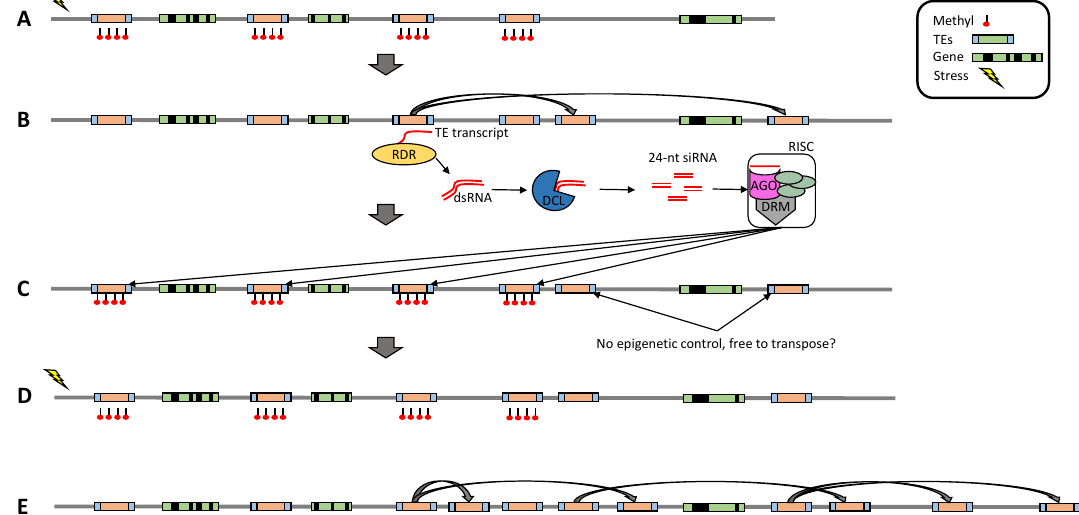
Figure 3. Potential mechanism of genome size increase due to TEs. ( A ) Multiple copies of a TE are demethylated upon stress; ( B ) TEs jump to new locations increasing genome size. At the same time, TE transcripts are recruited by an RNA-dependent RNA polymerase (RDR) to generate a double stranded RNA (dsRNA) that is broken down into double stranded 24-nt siRNAs by a DICER (DCL) protein. siRNAs are loaded to Argonaute proteins (AGO) which form a RISC complex (RNA-induced silencing complex) with methyltransferases (DRM) and other proteins. The siRNA binds to complementary target RNAs being produced in the multiple TE copies bringing the complex into place to promote methylation; ( C ) The RISC complex promotes methylation of multiple TEs but as more copies of TEs transpose to novel locations, resource limitation makes methylation less effective in some of the TEs, leaving some partially or completely unmethylated. Such TEs could now transpose more freely without epigenetic control; ( D , E ) A new stress triggers the process again further increasing genome size. As more copies of a TE are dispersed through the genome, epigenetic mechanisms for silencing all copies become increasingly